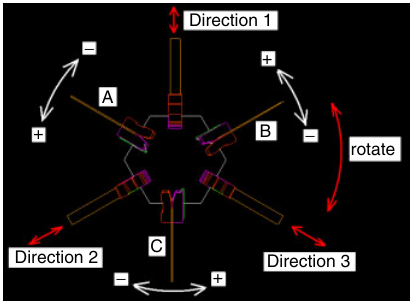
Figure 12 The DOFs of Walker-2.